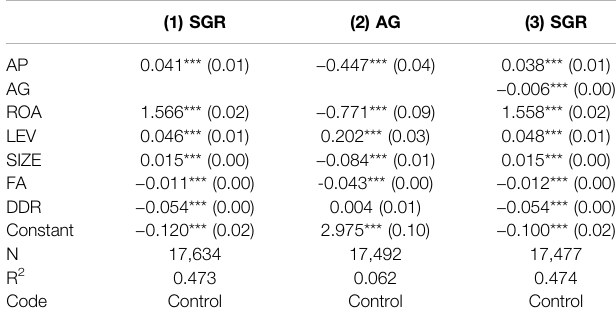
TABLE 11 | Analysis of AP in fl uence